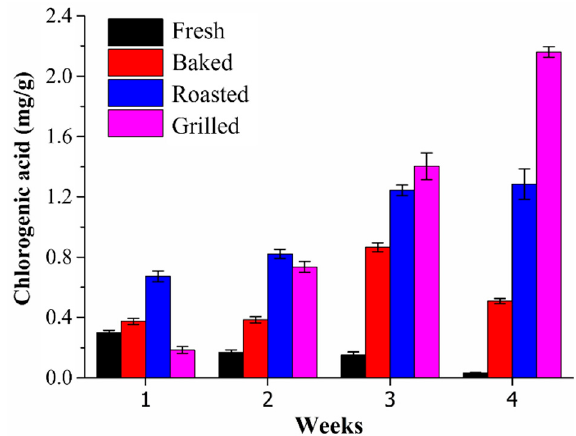
Figure 5. E ff ect of storage time on chlorogenic acid content (mg / g, FW) in the eggplant sample from Figure 5. Effect of storage time on chlorogenic acid content (mg/g, FW) in the eggplant sample from Spain after di ff erent cooking Spain after different cooking procedures.